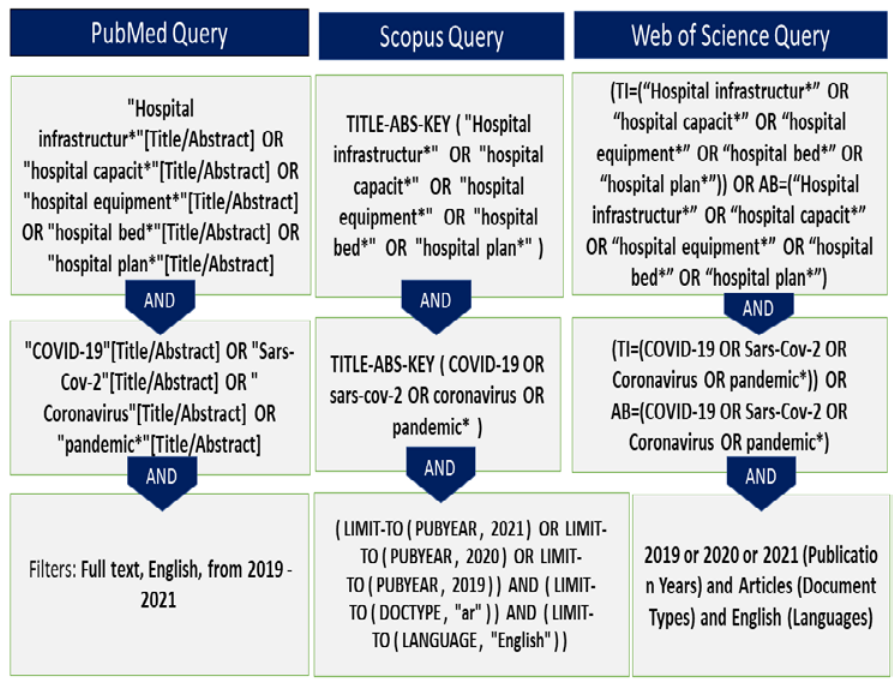
Figure 2. Search strategy query in three databases: PubMed, Scopus, and Web of science.